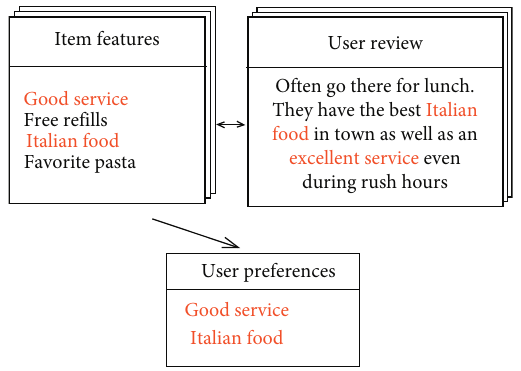
Figure 2: The process of obtaining the user short-term preferences from user